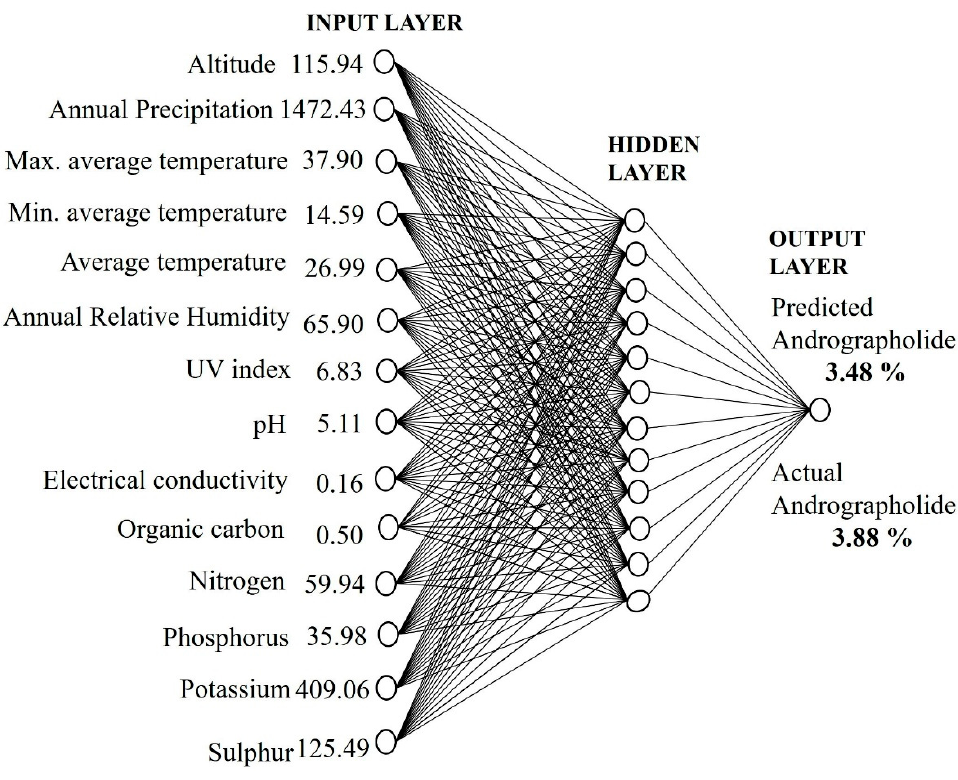
Figure 5. Application of the ANN model at an unknown site for prediction of andrographolide content.